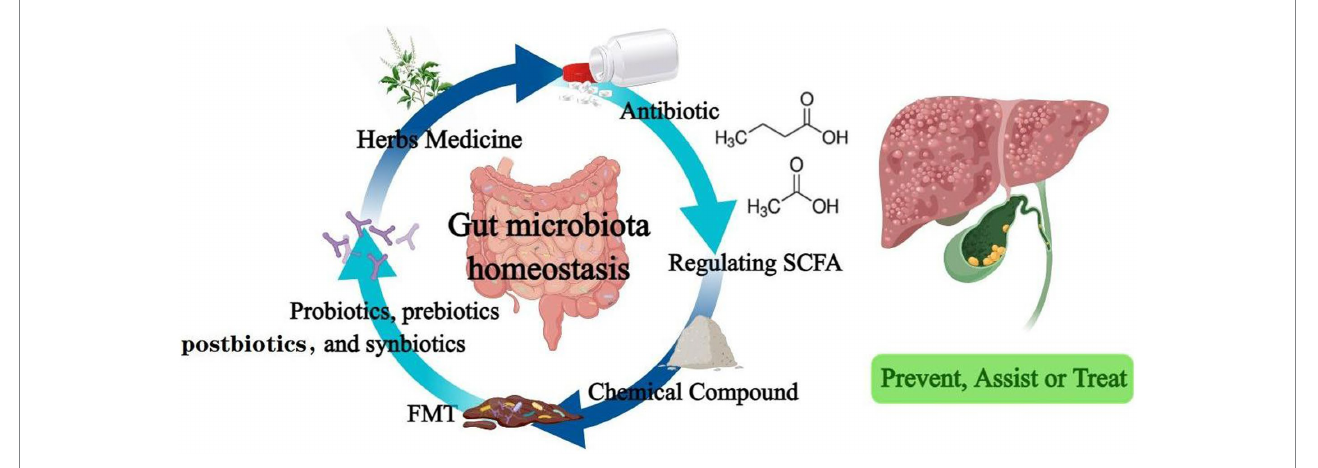
FIGURE 2 Drugs that regulate intestinal flora effectively prevent, assist or treat hepatobiliary